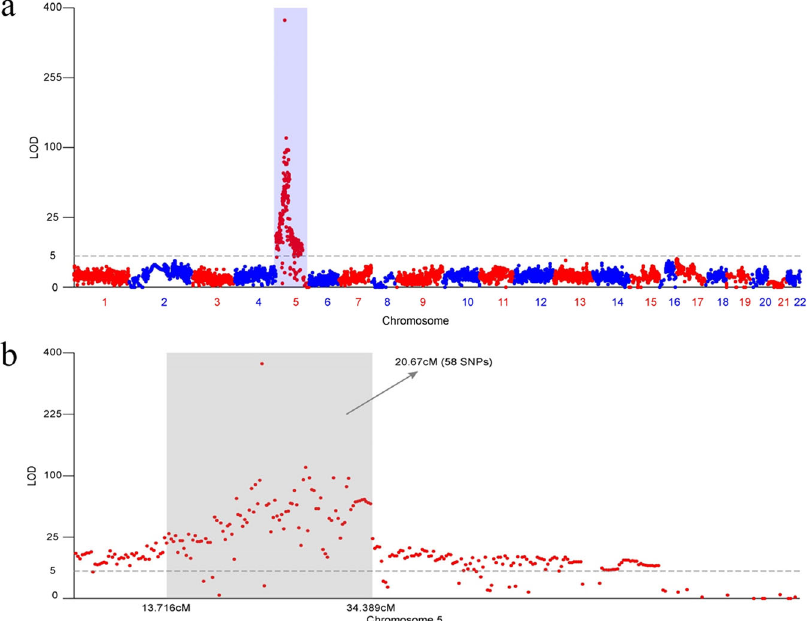
Fig. 2 QTL mapping of sex linkage in yellowstripe goby. a Genome-wide LOD (Likelihood ratio statistic) score for tests of genotype difference between sexes, arranged by chromosome. The gender-related signal is occurred only at chromosome 5. b A 20.67-cM-broad peak (sex-association QTL search) on chromosome 5.